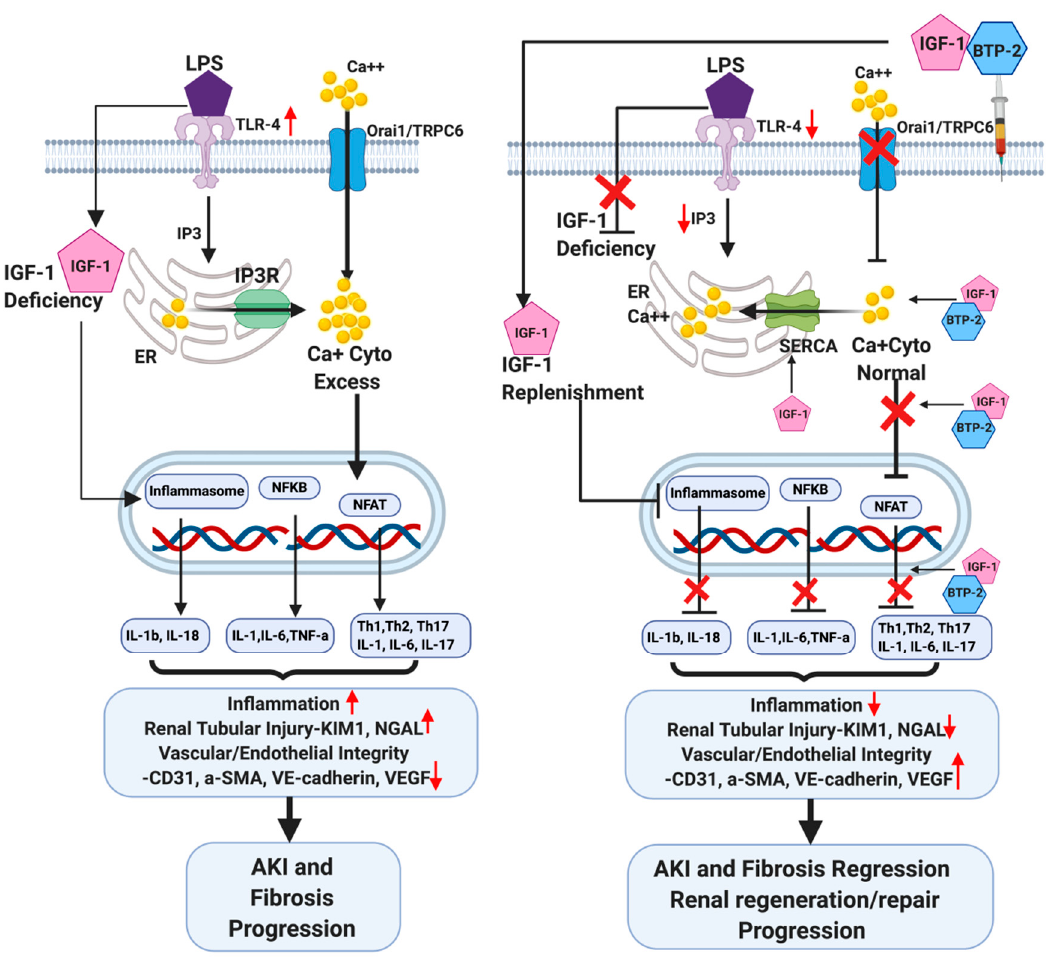
Figure 10. Schematic molecular pathway responses to the induction of AKI by LPS and the preventative therapeutic counteractions by IGF-1 and BTP-2. The left panel shows the effects of LPS, while the right panel shows the effects of combination therapy, IGF-1 + BTP-2. LPS initiates the destructive process by activating TLR-4, which leads to an enhancement of IP3 receptor activity in the ER, which in turn enhances the calcium reflux from the ER to the cytosol. The depletion of ER calcium activates plasma membrane calcium influx, via Stim, through Orai1/TRPC6 channels. The consequent increase in cytosol calcium propels the pathway that leads to inflammation and injury, as described in the text. On the right panel, the red X indicates the sites of action of combination therapy (IGF-1 + BTP-2), which had positive effects on all of the adverse system changes caused by LPS administration. The action of BTP-2 is to specifically inhibit Orai1 and TRPC6, which counteracts the effect of LPS on calcium influx into the cytosol. The function of BTP-2 to inhibit the calcium channel regulator is complemented by IGF-1, which acts on SERCA to increase calcium influx into the ER from the cytosol. The consequent decrease in cytosolic calcium counteracts much of the adverse actions of LPS, as described in the text.